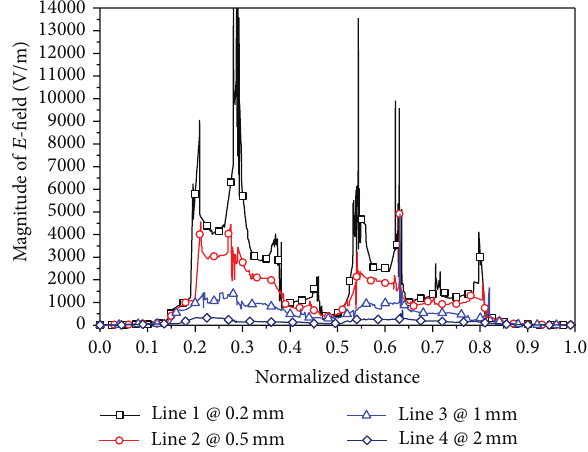
Figure 16: Total 𝐸 -fields in near-field zone along four different assessing lines. The lines are shown in Figure